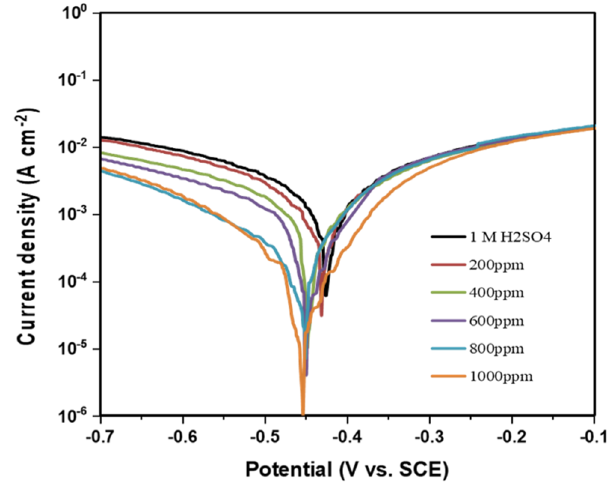
Figure 9. Potentiodynamic polarization curves for MS in 1M H 2 SO 4 containing different concentra- tions of inhibitor, when polarization is done immediately after 3 h of immersion.